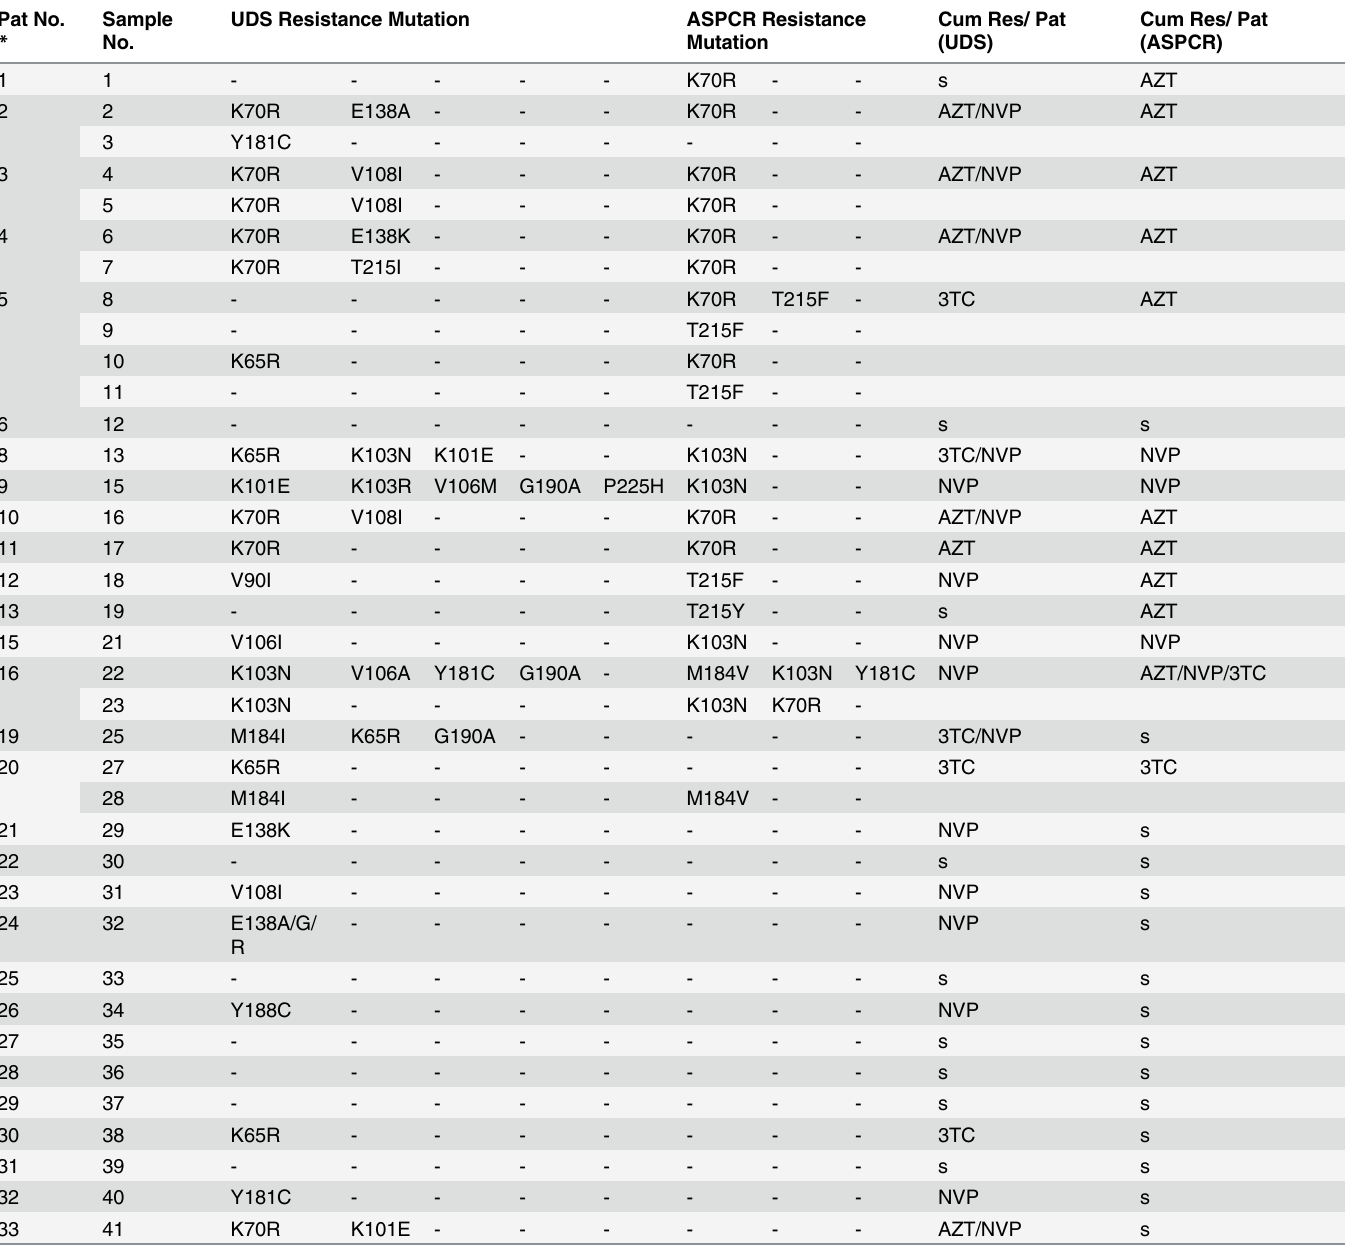
Table 4. Prediction of drug-resistance based on UDS and ASPCR results. Pat No. Sample *